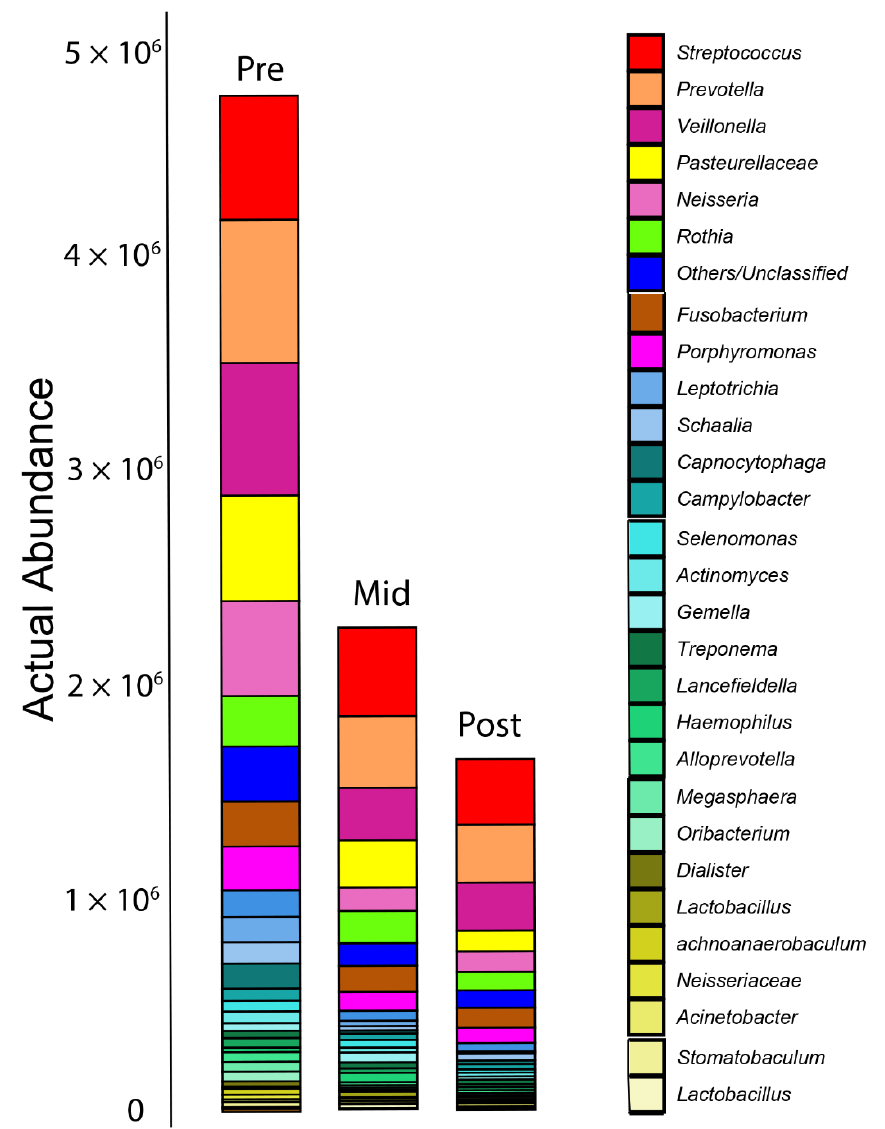
Figure 5. Bar plot for abundance profiling of the oral microbiome. Only the top 30 taxa are shown here as the core bacterial microbiota within the oral cavity. Actual abundance analysis shows a significant reduction in the overall oral microbiome taxa due to radiotherapy.